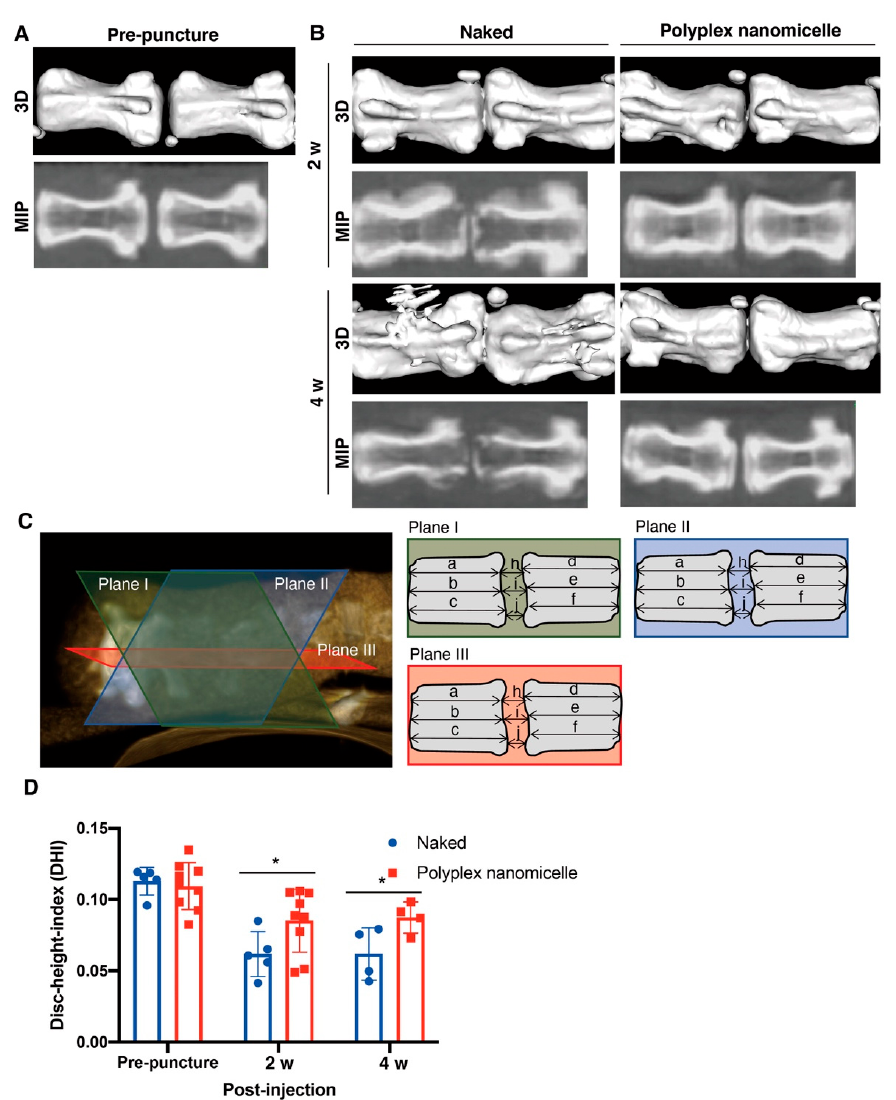
Figure 5. μ CT examination to detect the shrinkage of the punctured disc. ( A ) Images from the pre-punctured animal. Representative μ CT images present the 3D reconstruction and maximum inten- sity projection (MIP). ( B ) Images from the post-punctured animal. Runx1 mRNA was injected in naked form compared with that loaded in polyplex nanomicelle form, and μ CT was carried out at 2- and 4-weeks post-injection. ( C ) Schematic presenting the images retrieved from three sagittal planes used to analyze the DHI. ( D ) DHI calculation according to the equation shown in the Mate- rials and Methods to represent the degree of disc shrinkage. n = 4; * p < 0.05.